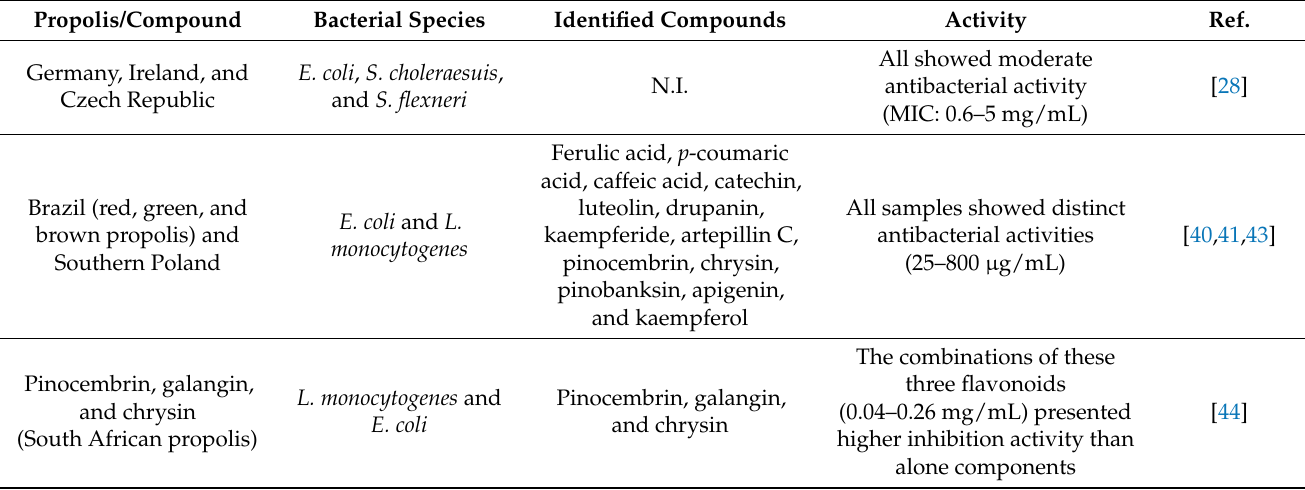
Table 5. Antibacterial activity of different propolis on various microorganism